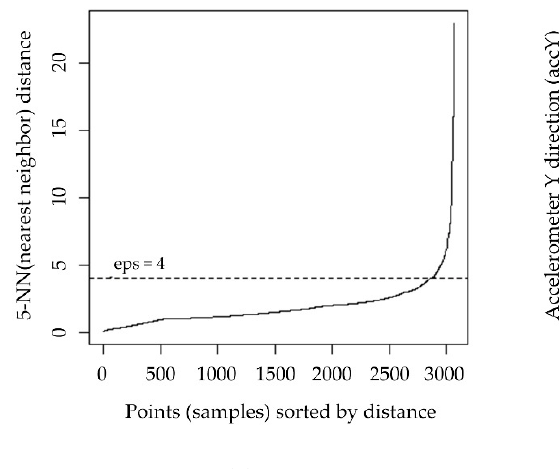
Figure 5. Attribute significance (attribute labels are defined in the main text above).